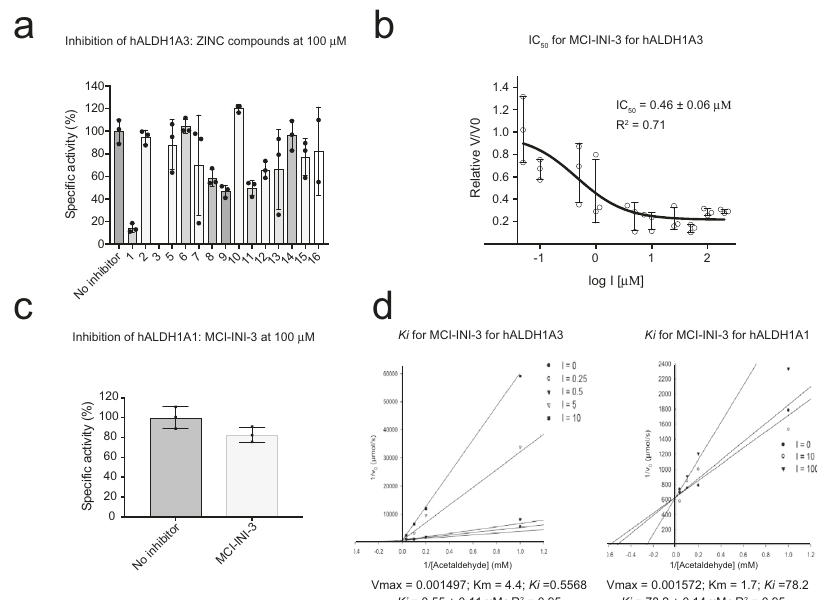
Fig. 5 Biochemical characterization of MCI-INI-3 inhibition of ALDH1A1 and ALDH1A3. a Histogram representation of the speci fi c residual enzymatic activity of ALDH1A3 in the presence of 100 µ M inhibitor concentration of the selected inhibitor compound and in absence of any inhibitor ( fi rst column on the left; n = 3, technical replicates). b Graphical representation of MCI-INI-3 IC 50 for ALDH1A3 ( n = 3, technical replicates). c Histogram representation of the speci fi c residual enzymatic activity of ALDH1A1 in the presence of 100 µ M MCI-INI-3 and with no inhibitor. ALDH1A1 retains 92% of its speci fi c activity with 100 µ M MCI-INI-3 ( n = 3, technical replicates). d Steady-state enzyme kinetics with MCI-INI-3 for ALDH1A3 and ALDH1A13. The experimental procedure is detailed in the Material and Methods section and the reported values represent the average of three independent experiments. Each line represents linear regression analysis of the reciprocal of average simulated rates of product formation for different substrate concentrations as a function of inhibitor concentration. IC 50 and K i values are